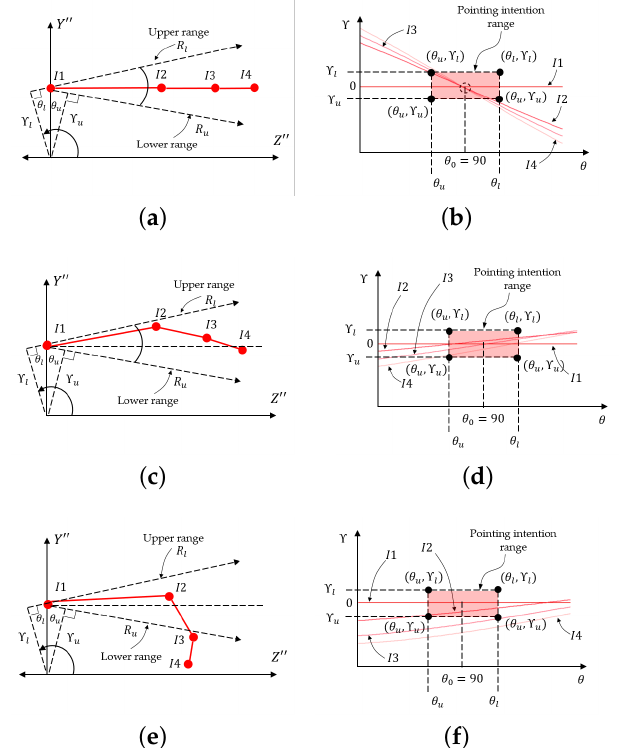
Figure 15. Index fingers with Hough transform: ( a ) Straight index finger, ( b ) Straight index finger in Hough domain, ( c ) Bending index finger considered as straight, ( d ) Bending index finger in Hough domain, ( e ) Straight index finger with failed determination, and ( f ) Failed straight index finger in Hough domain.